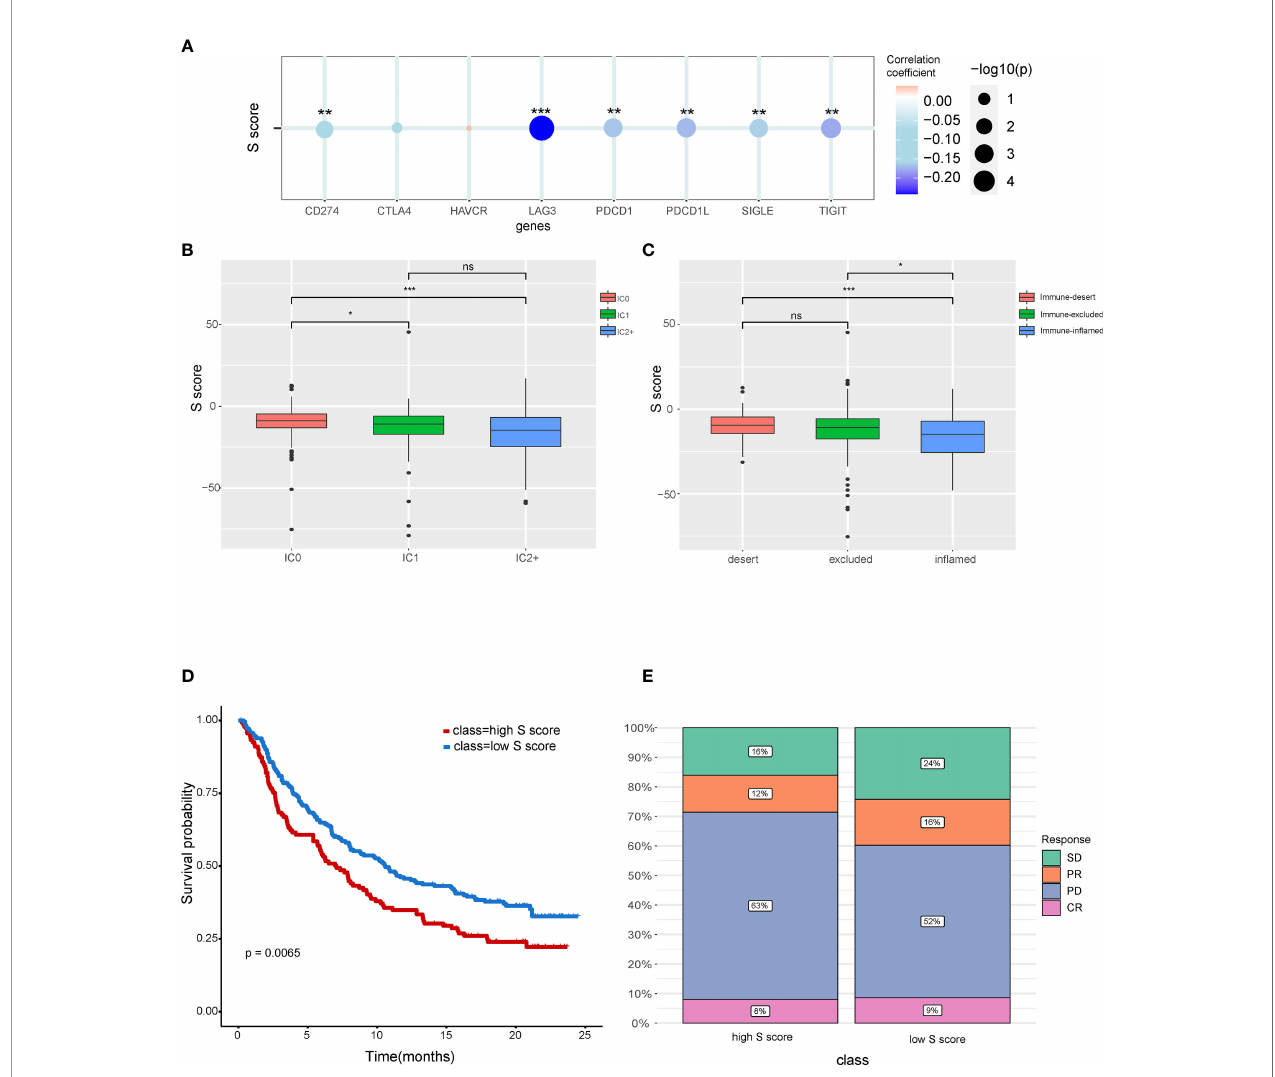
FIGURE 7 | The potential of the S score in predicting response to immunotherapy in cancer. (A) The correlation between the S score and immune checkpoints. (B) Comparison of S score in different ICs (IC) groups. (C) Comparison of S score in groups with different immune microenvironment characteristics. Samples have been classi fi ed into three immune microenvironment-related subtypes: immune-deserted, immune-in fl amed, and immune-excluded. (D) Comparison of prognosis of patients in high – and low – S score groups. (E) Distribution of responsive status in high – and low – S score groups. SD, stable disease; PD, progressive disease; PR, partial response; CR, complete response. *P < 0.05, **P < 0.01, and ***P < 0.001. NS, Not Signi fi